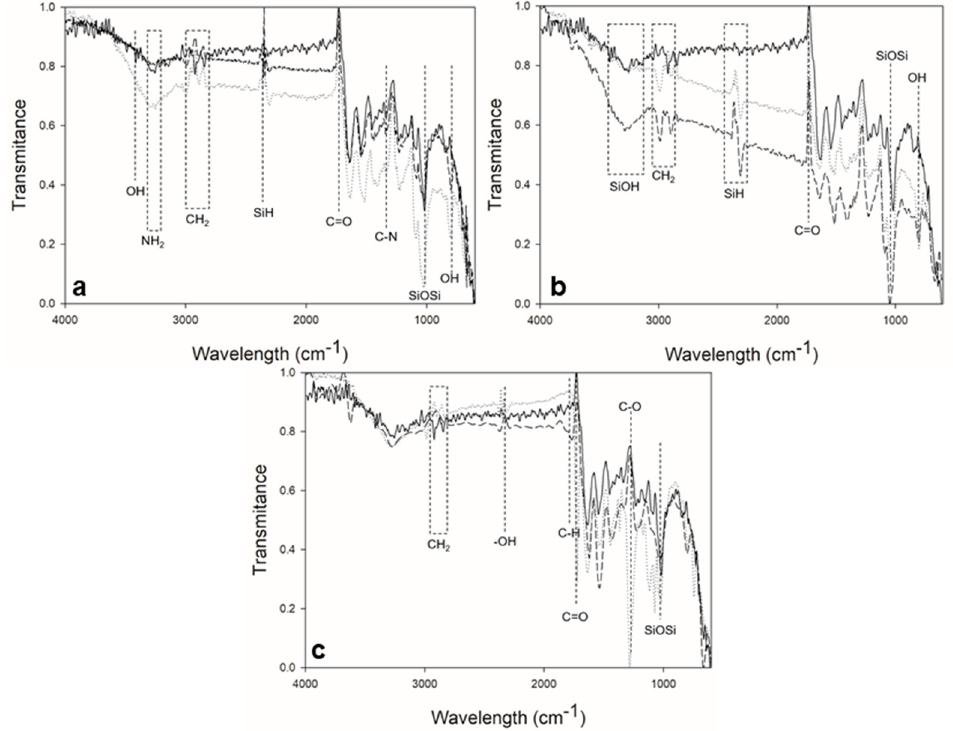
Figure 4. FTIR spectra of APTES ( a ), TEOS ( b ) and DODEC ( c ) for Leather (-), Leather functionalized with a silane ( ... ) and leather functionalized with a silane and glutaraldehyde (--).